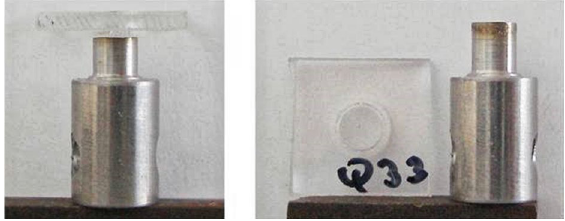
Fig. 4. Joint before and after tearing test